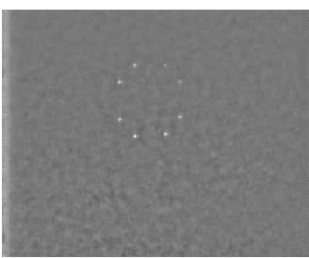
KR G = + ). Figure 10. Image K ( K = R + G L /2 L /2). LL